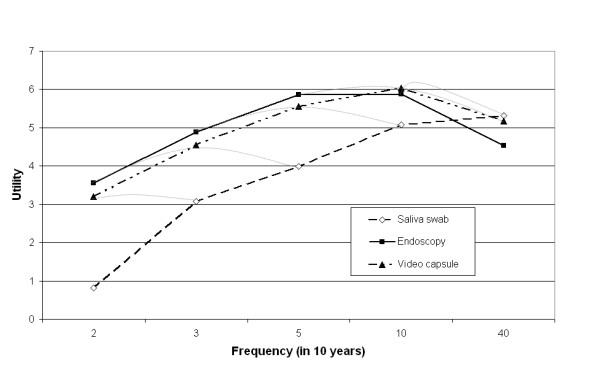
Utility of endoscopic surveillance by test and frequency (reference = no surveillance, the x-axis).